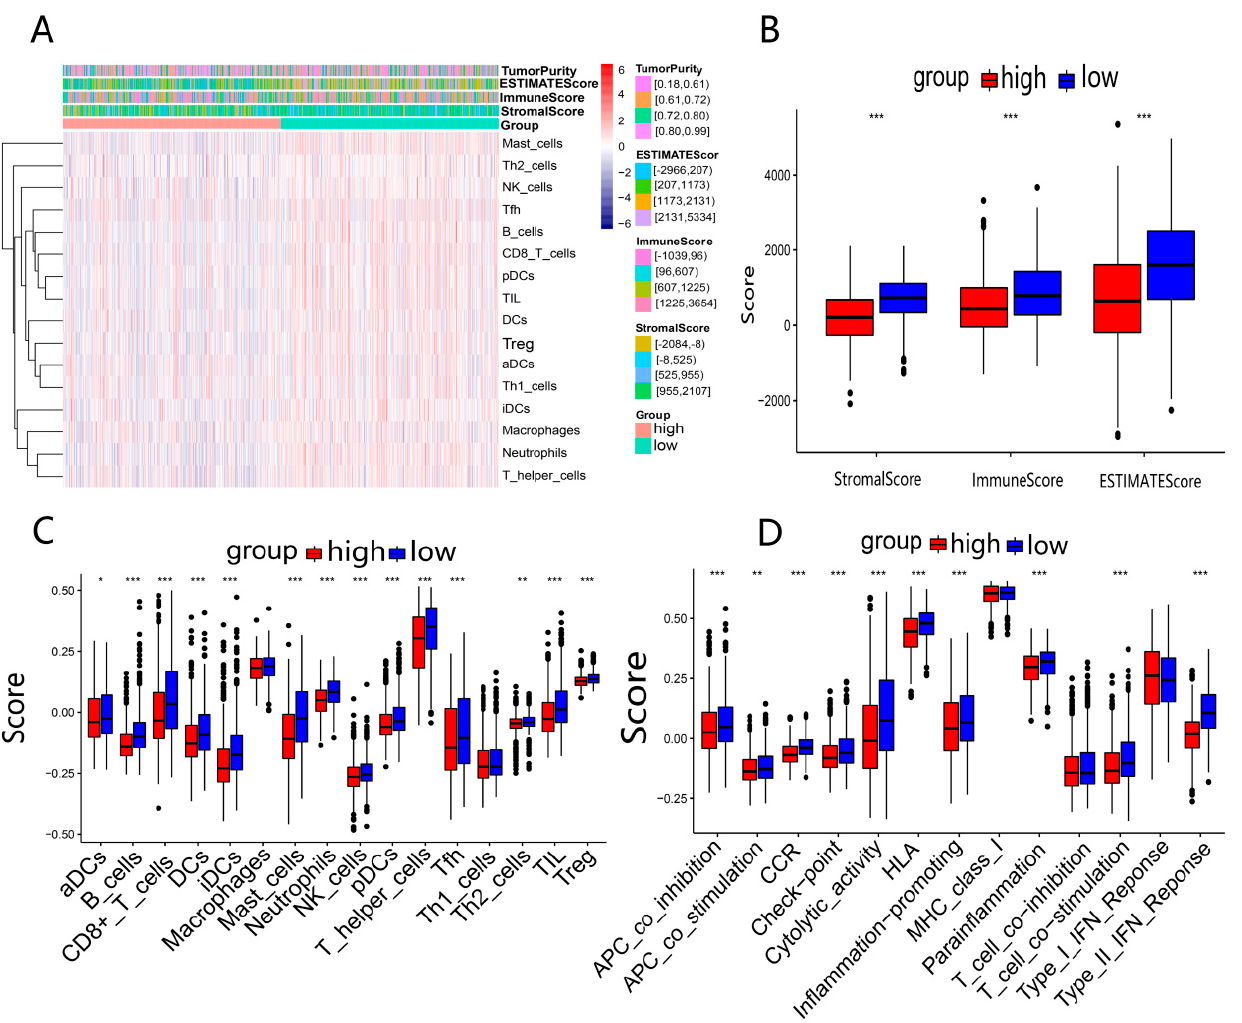
Figure 8. Analysis of immune activity in 2 risk groups in TCGA-BRCA: ( A ) comparison of enrichment levels of immune cells and types between 2 risk groups; ( B ) box plots used to compare the immune score, stromal score, and ESTIMATE score for 2 risk groups; ( C , D ) comparison of enrichment scores for 16 immune cells and 13 immune-related pathways between 2 risk groups. * p < 0.05; ** p < 0.01; *** p < 0.001.